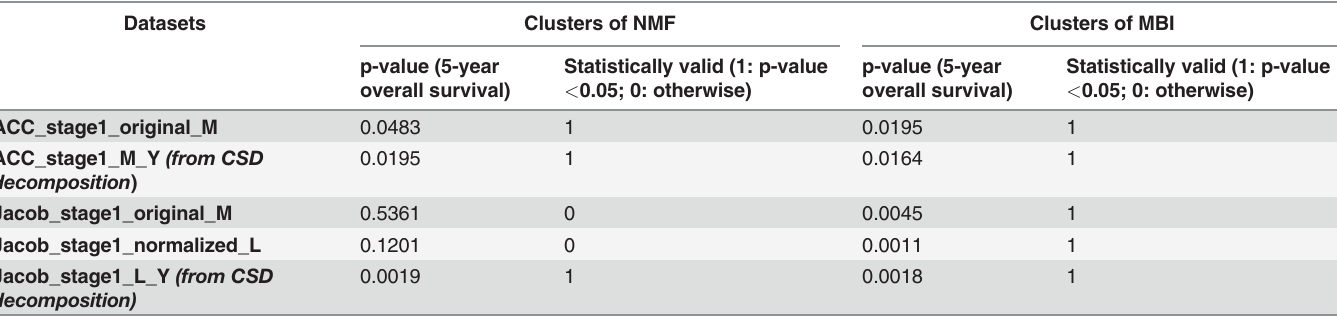
Table 2. Performance comparison of NMF (k = 2, i.e., 2 sample clusters) and MBI (k 1 = 100, k 2 = 2) on different stage I lung ADCA datasets.